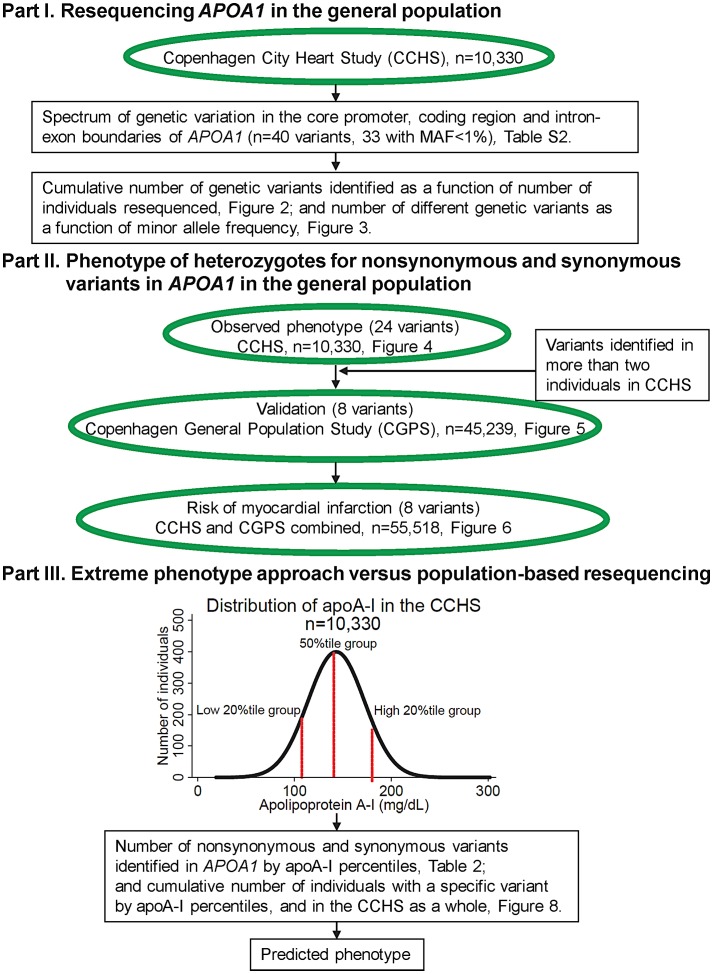
Study design.MAF = minor allele frequency.